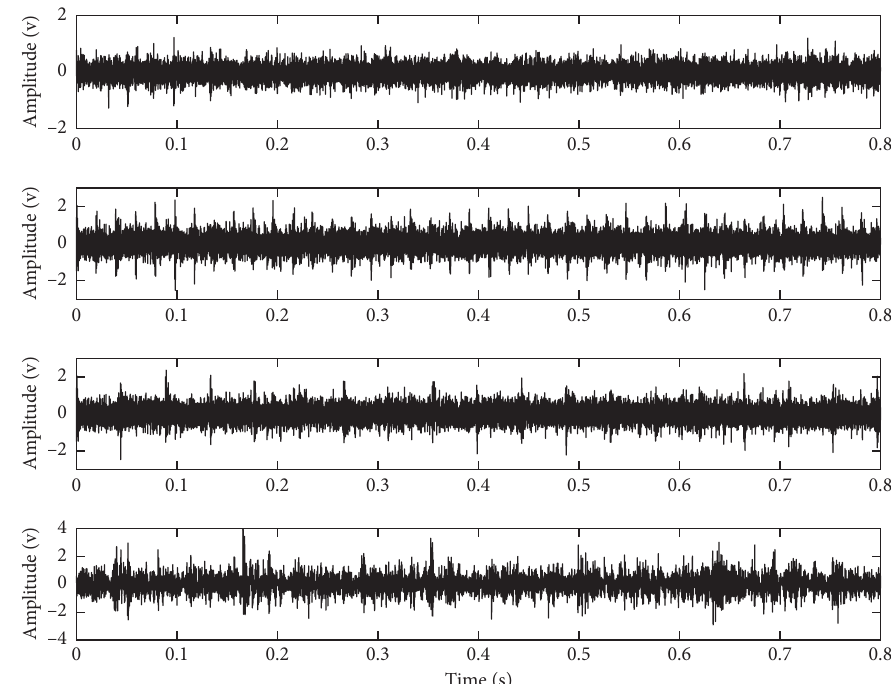
Figure 18: The 4 separated